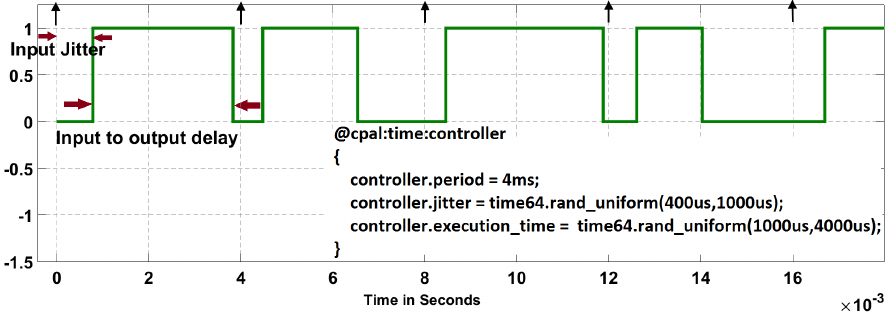
Figure 2. Simulating random input and output jitters affecting a CPAL controller model using timing annotations. Level 1 means that the controller is being